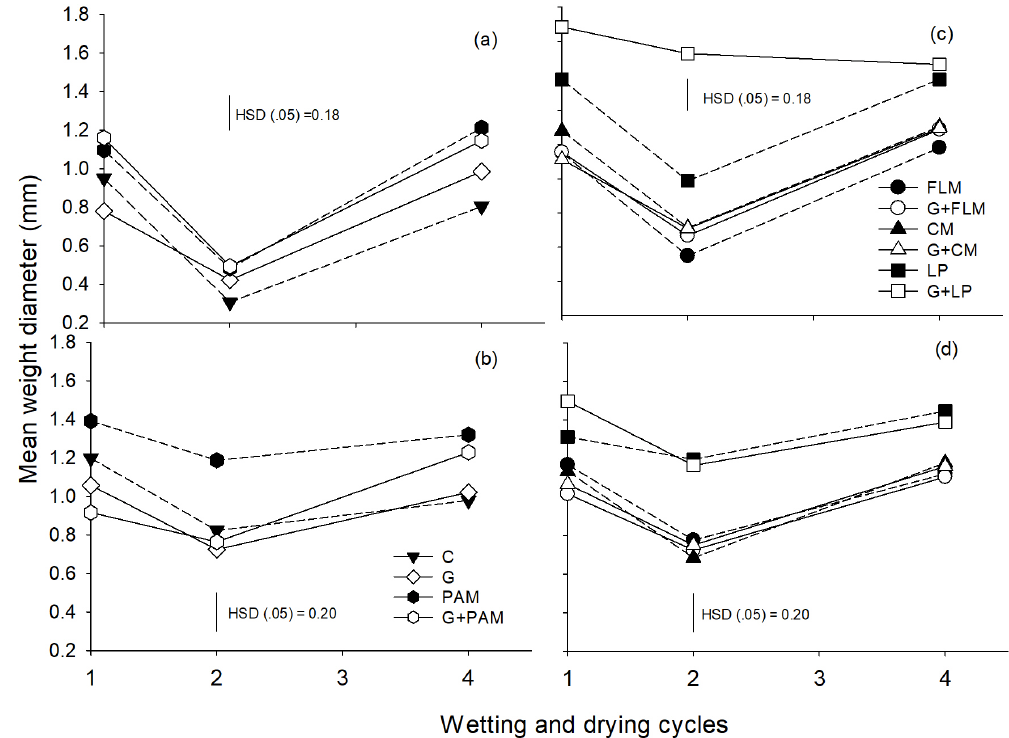
Figure 2. The mean weight diameter (MWD) of the soils after addition of amendments during four wetting and drying (WD) cycles, Soil 1 (a, c) and Soil 2 (b, d) . The treatments are C: control, G: gypsum, PAM: anionic polyacrylamide, FLM: feedlot manure, CM: chicken manure, and LP: lucerne pellets. Vertical bars represent Tukey’s honest significant difference (HSD) values at p = 0 . 05 for pairwise comparisons among